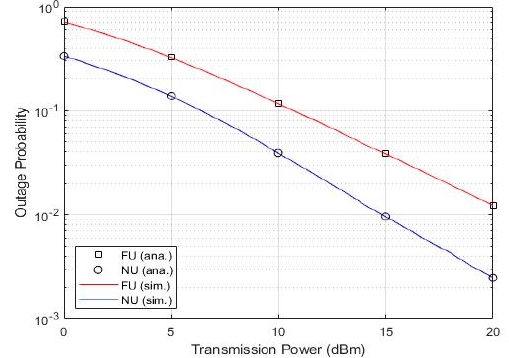
Figure 6. Users’ Outage Probability vs. Transmit Power.